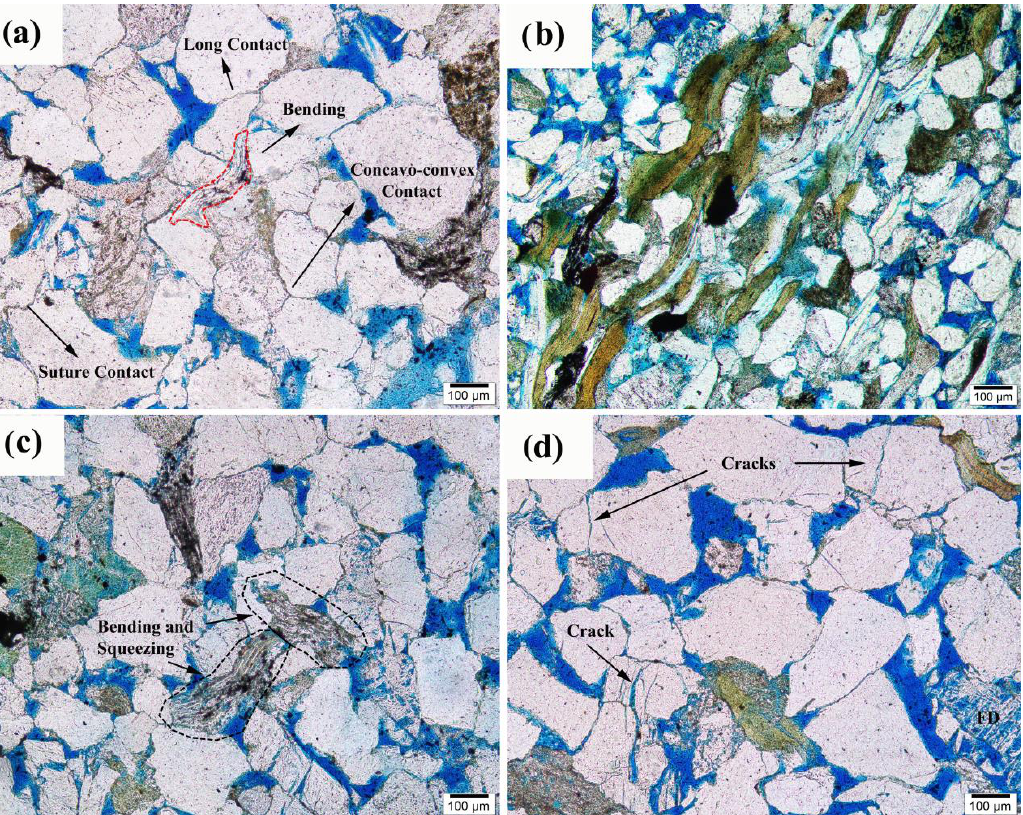
Figure 8. Photomicrograph showing the impact of the mechanical compression of the Srikail-3 well ( a ) long, concavo-convex, suture contact and bending of ductile grain at 3182 m depth; ( b ) ductile grain compaction (biotite) at 3181 m depth; ( c ) bending and squeezing of lithic grains at 3184.5 m depth; ( d ) a crack develops in brittle grains due to compaction, feldspar dissolution (FD) at 3183.5 m depth.